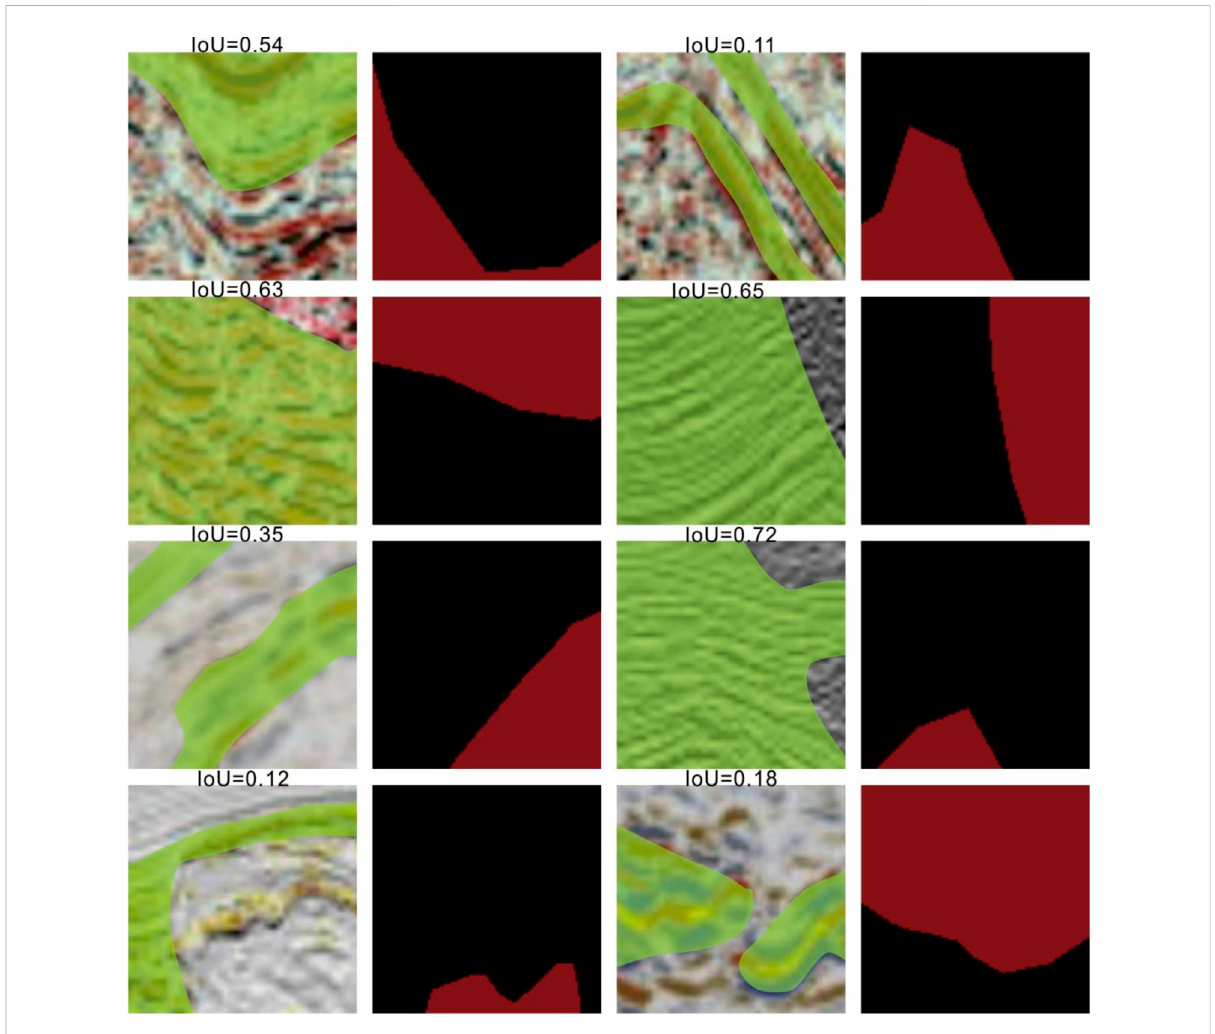
FIGURE 6 The stage 1 performance for background detection, with intersection over union (IoU) values (the green part is the background; in the segmented images, the red part is the salt structure and the black part is the